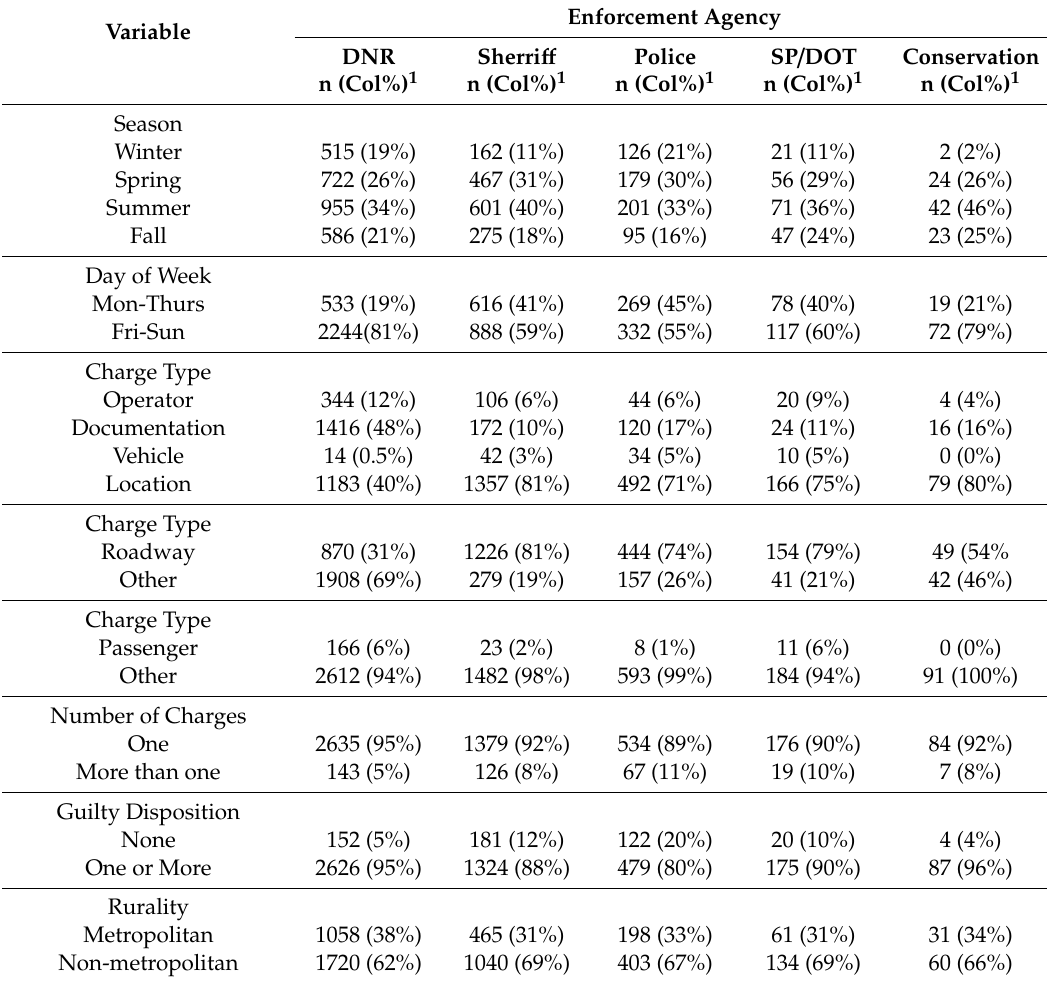
Table 4. Comparisons by enforcement agency and by county presence of an o ff -highway vehicle (OHV) park for o ff -road vehicle (ORV) citations in the Iowa Courts Information System (ICIS) from